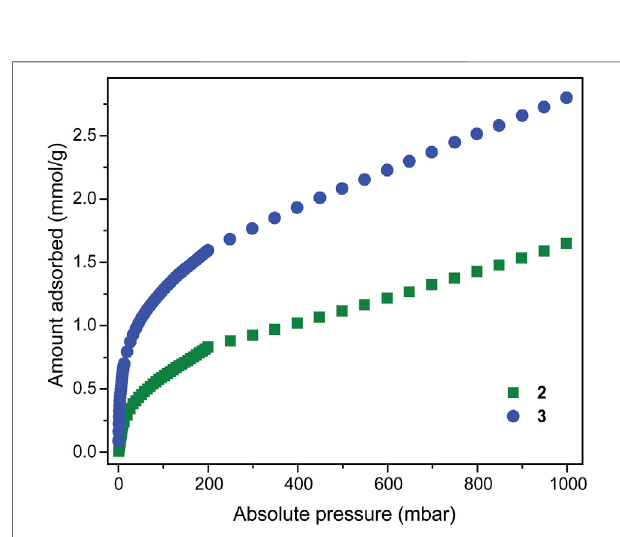
FIGURE 5 | 195 K CO 2 isotherm of MOF 2 (green squares) and cross- linked polymer 3 (blue